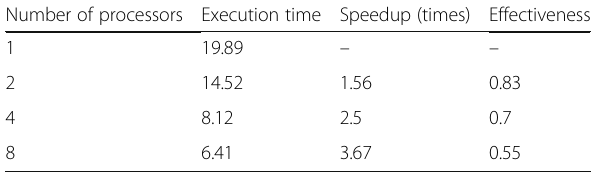
Table 2 Comparison of different numbers of processors Number of processors Execution time Speedup (times) Effectiveness